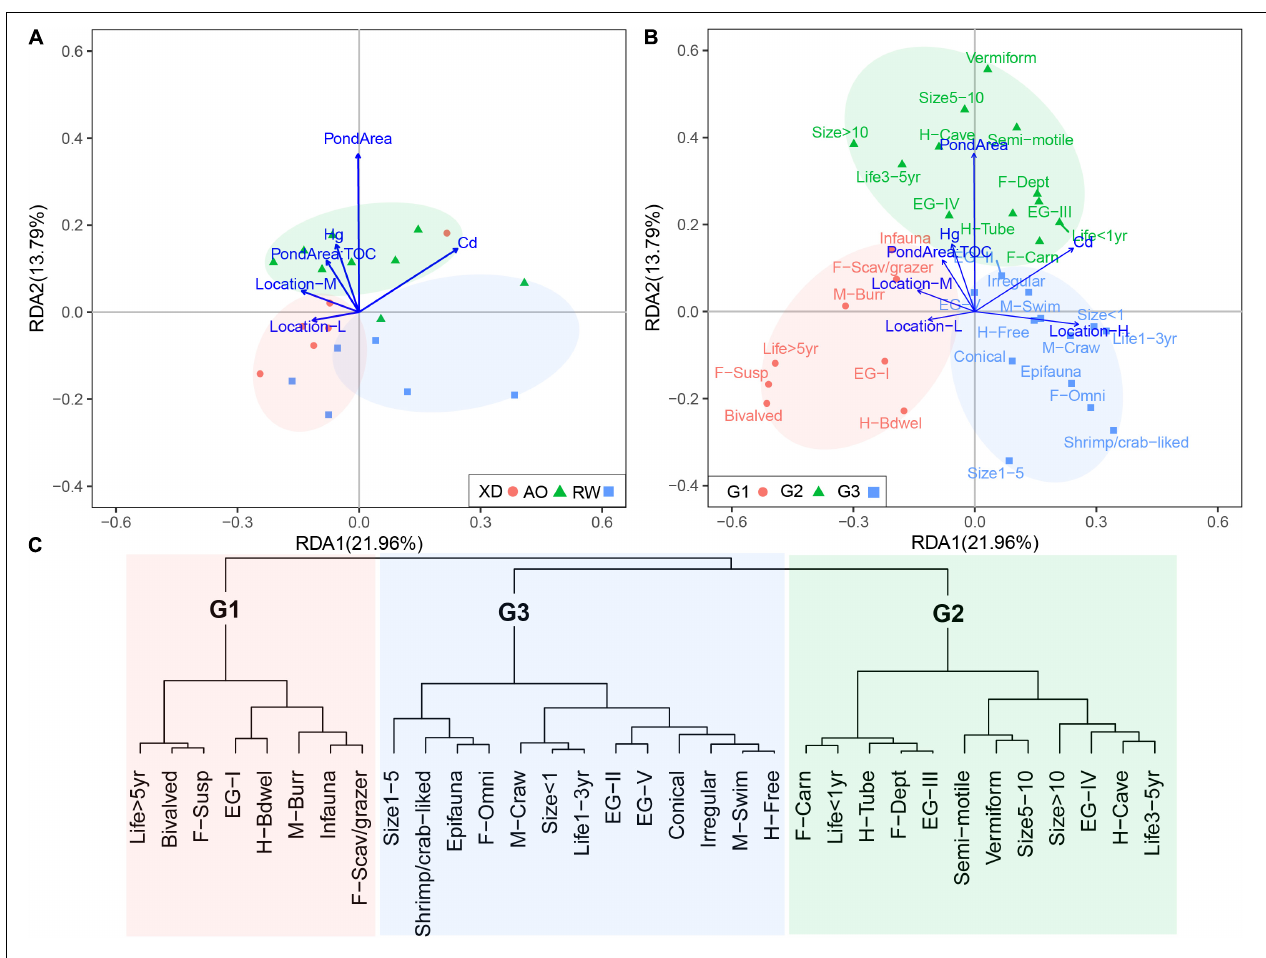
FIGURE 7 | The results of redundancy analysis (RDA) of macrobenthic communities in three intertidal zones in Laoshan Bay. (A) Environmental variables vs. sites, (B) environmental variables vs. trait modalities, groups referred to panel (C) , (C) groups of trait modalities based on the cluster analysis of Euclidean distance of the coordinates of trait modalities along the first two axes of RDA. For full labels of traits modalities, see Table 1